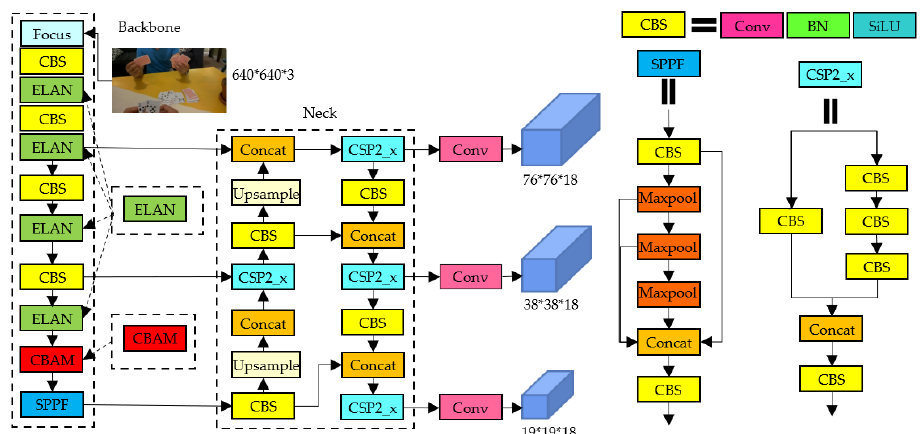
Figure 3. Network structure of the improved YOLOv5l algorithm.